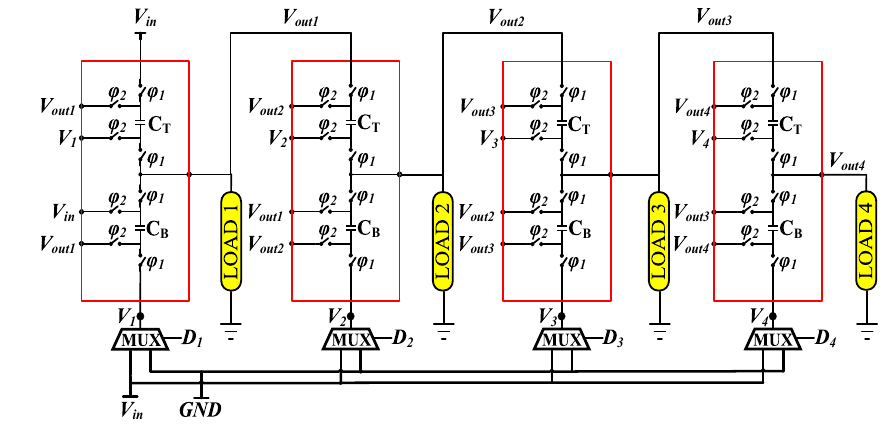
Figure 15. Schematic of the implemented 4-bit SSC-DVS.